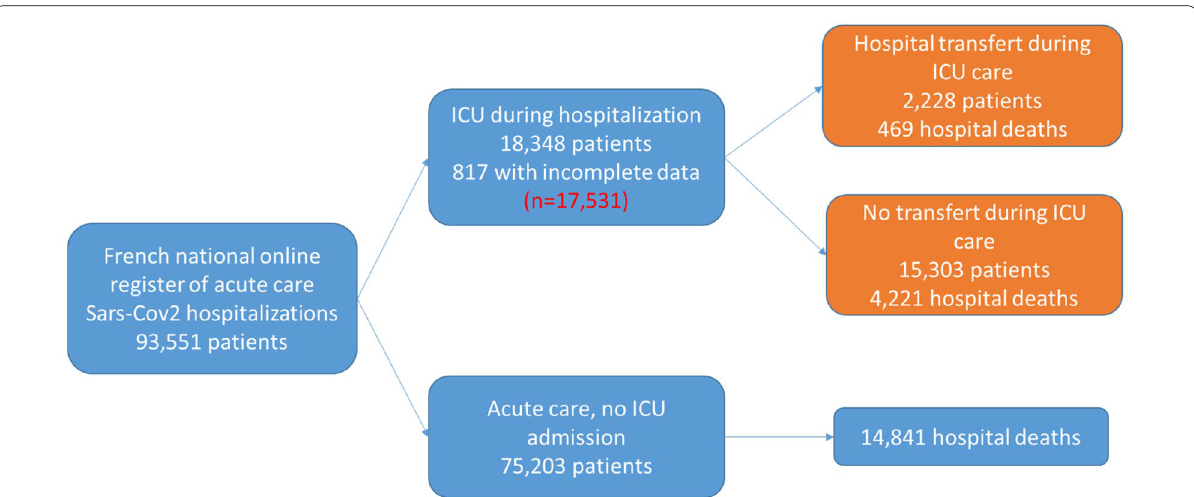
Fig. 1 Flowchart of patients with COVID‑19 from the SI‑VIC national registry in France from 1 March to 21 June 2020. 328 patients were lost to follow‑up during their ICU stay and 265 during acute care after ICU discharge because hospital staff did not update outcome information in the SI‑VIC system; 216 patients had missing information (age and sex) and eight patients were admitted to hospital prior to study commencement